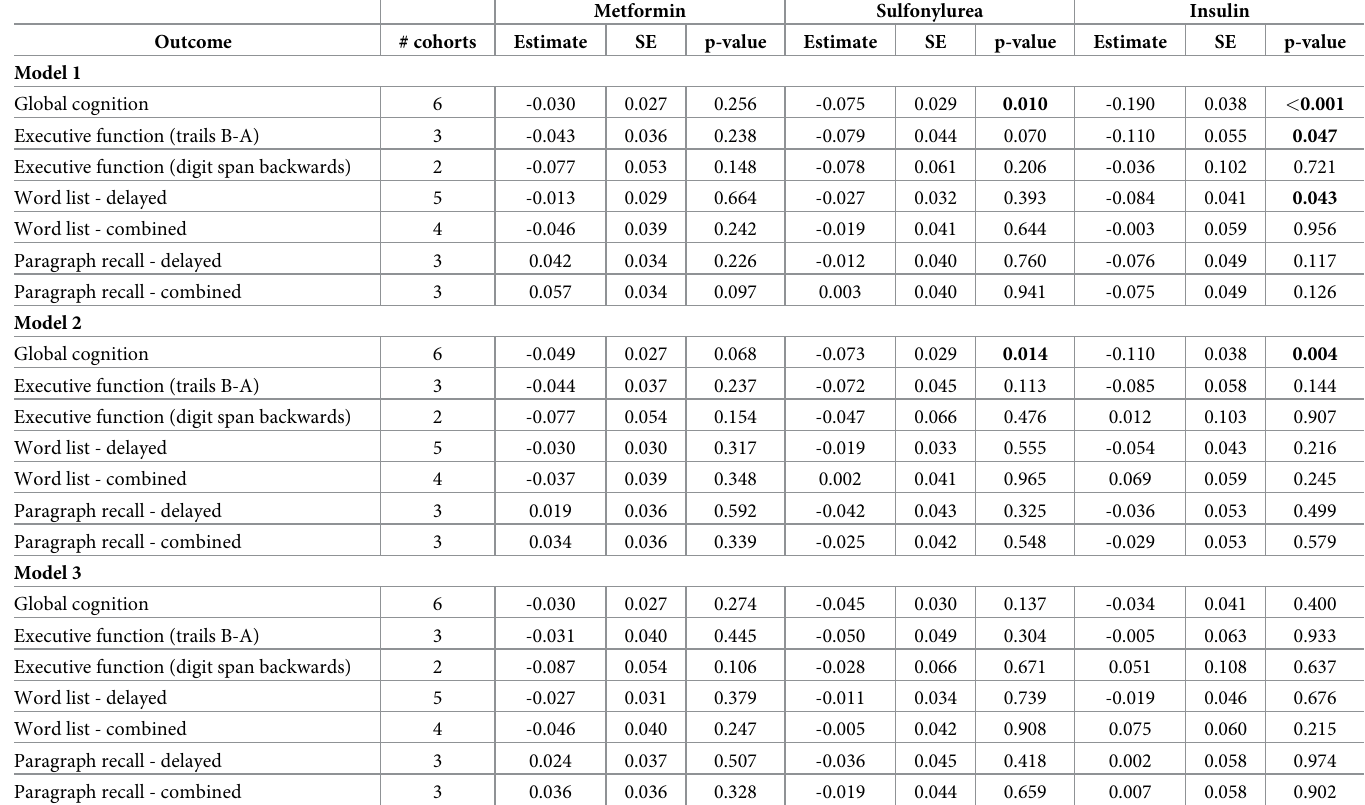
Table 3. Associations of diabetes drug classes (single or in combination) with cognitive performance among individuals with diabetes- fixed effects meta-analysis (dementia cases are included).